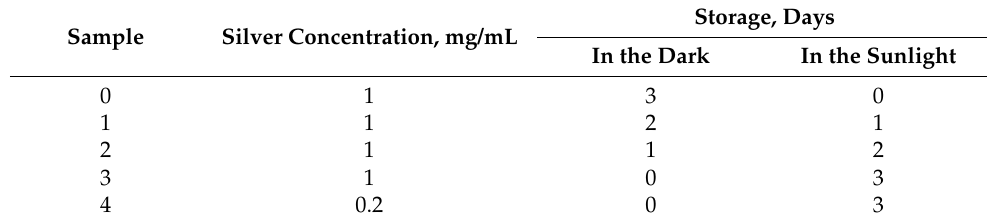
Table 1. Storage conditions for samples of silver chloride sol in experiment No. 3.